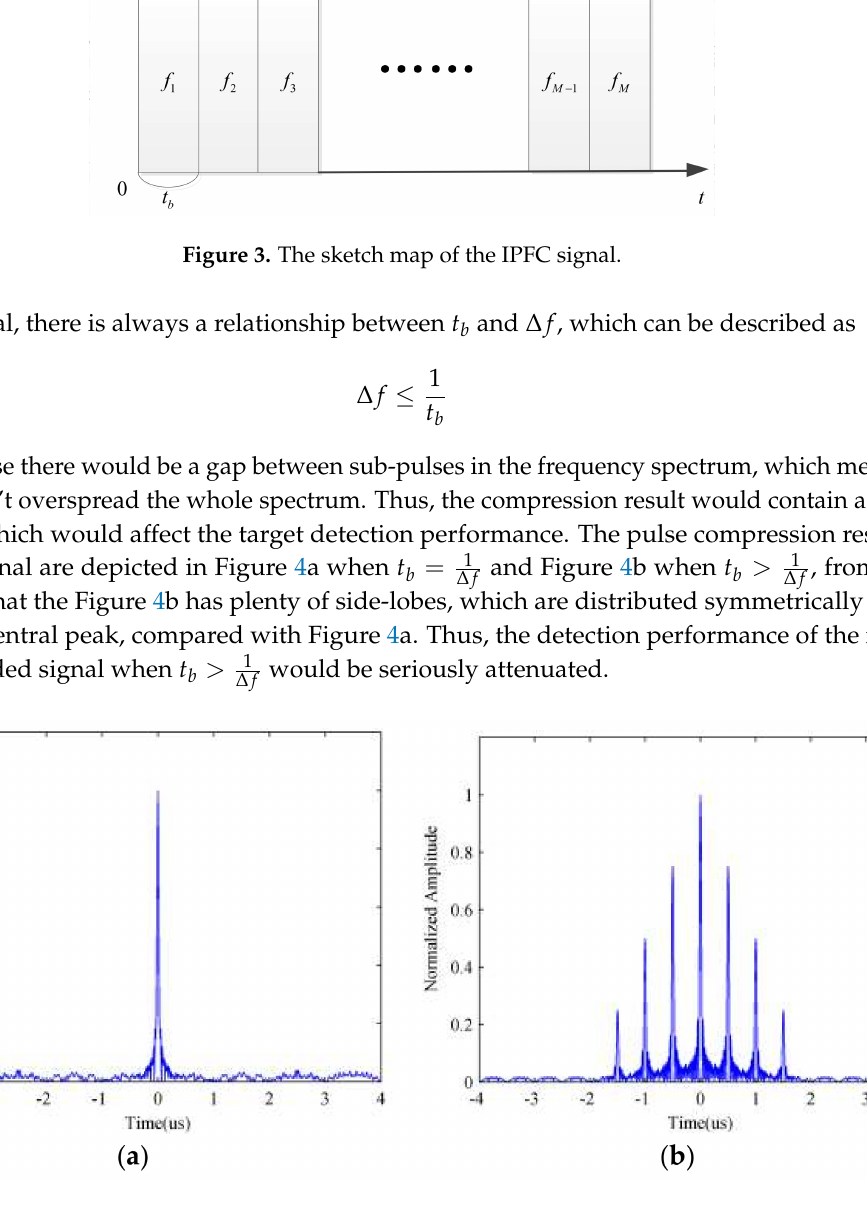
Figure 4. The pulse compression result of random signal with different parameters. Sub-pulse